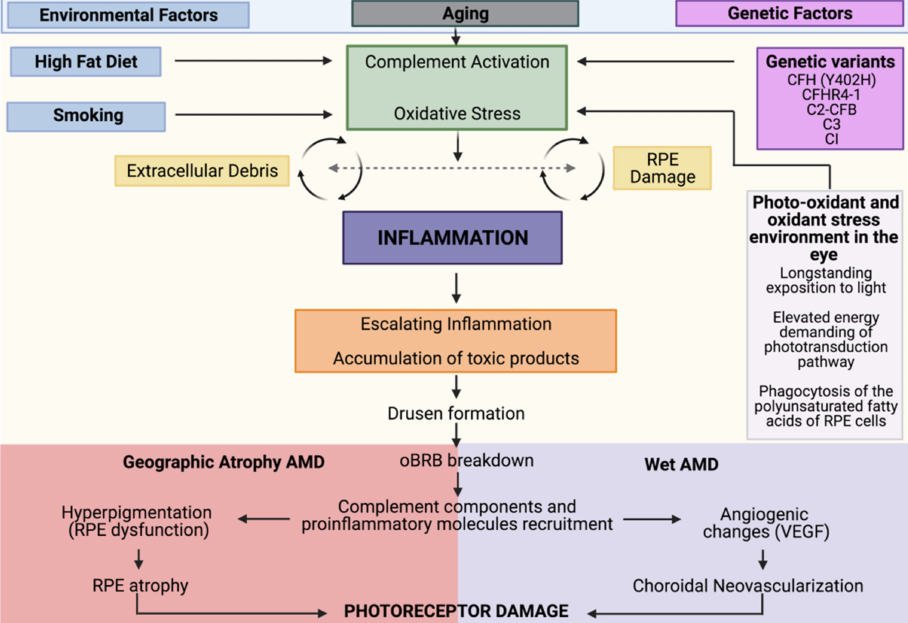
Figure 1. AMD pathobiology. Integrated model of AMD pathogenesis with a central involvement of inflammation. As individuals age, they experience increased oxidative stress, and complement dysregulation. The convergence of genetic (in magenta) and environmental (in blue) factors leads to a state in which the accumulation of toxic elements leads to a sustained activation of these pro-inflammatory and damaging pathways that culminates in advanced AMD. In the case of geographic atrophy (GA), sustained damage to the retinal pigment epithelium (RPE) leads to RPE and choriocapillaris degeneration. In neovascular AMD, breakdown of the outer blood–retinal barrier (oBRB) results in immune cell trafficking into the retina, which drives vascular endothelial growth factor (VEGF)-dependent neovascularization. Both forms ultimately result in photoreceptor damage and visual